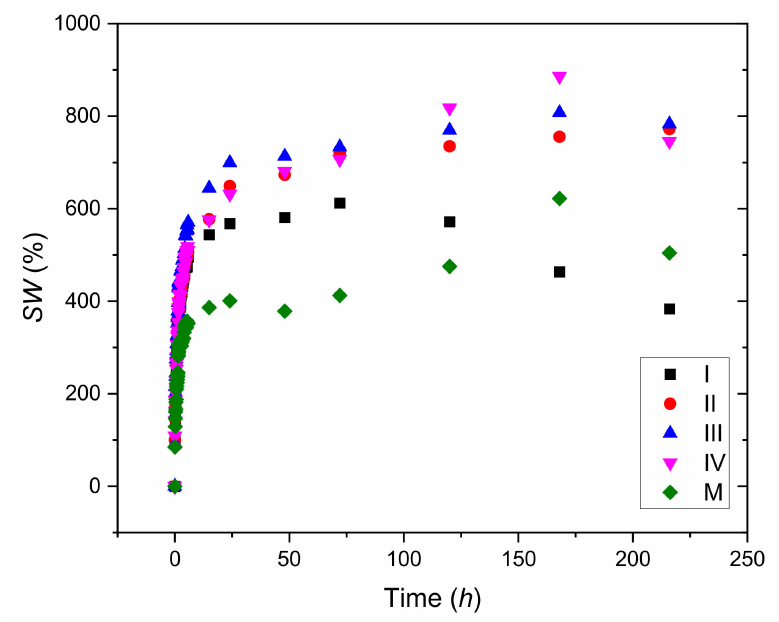
Figure 2. Swelling degree as a function of time for hydrogels samples with different concentrations of CuSO 4 × 5H 2